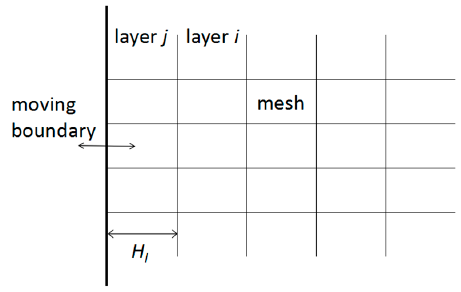
Figure 1. Dynamic layers of moving boundary.